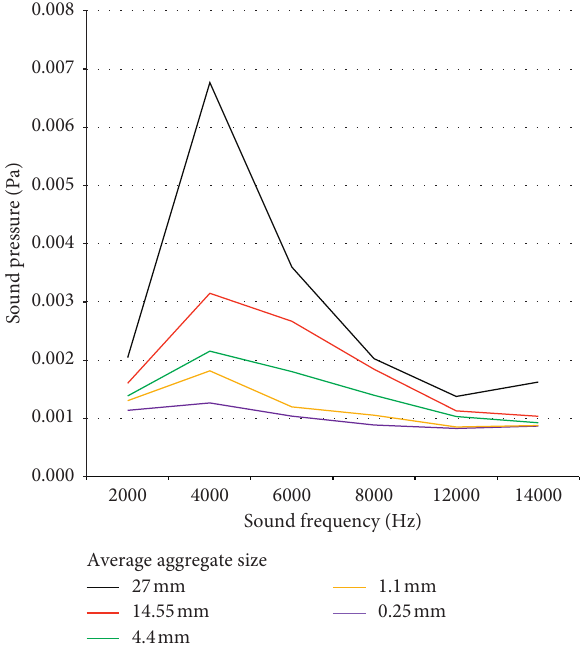
Figure 8: Typical spectral patterns of sound pressure while drilling on concrete specimens with different aggregate